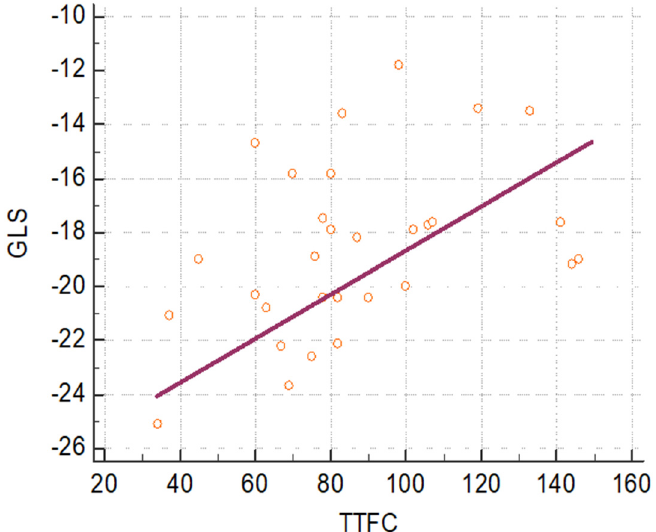
Figure 1. Scatter plot showing a statistically significant correlation ( p = 0.021) between GLS and tTFC of the population with INOCA (ischemia with non-obstructive coronary artery disease) and MVA (MicroVascular Angina). The correlation between the strains of the 18 myocardial segments with the TFC of the tributary vessel in the total population with INOCA was evaluated. A statistically significant correlation was observed between the longitudinal strain of the perfused segments from the right coronary